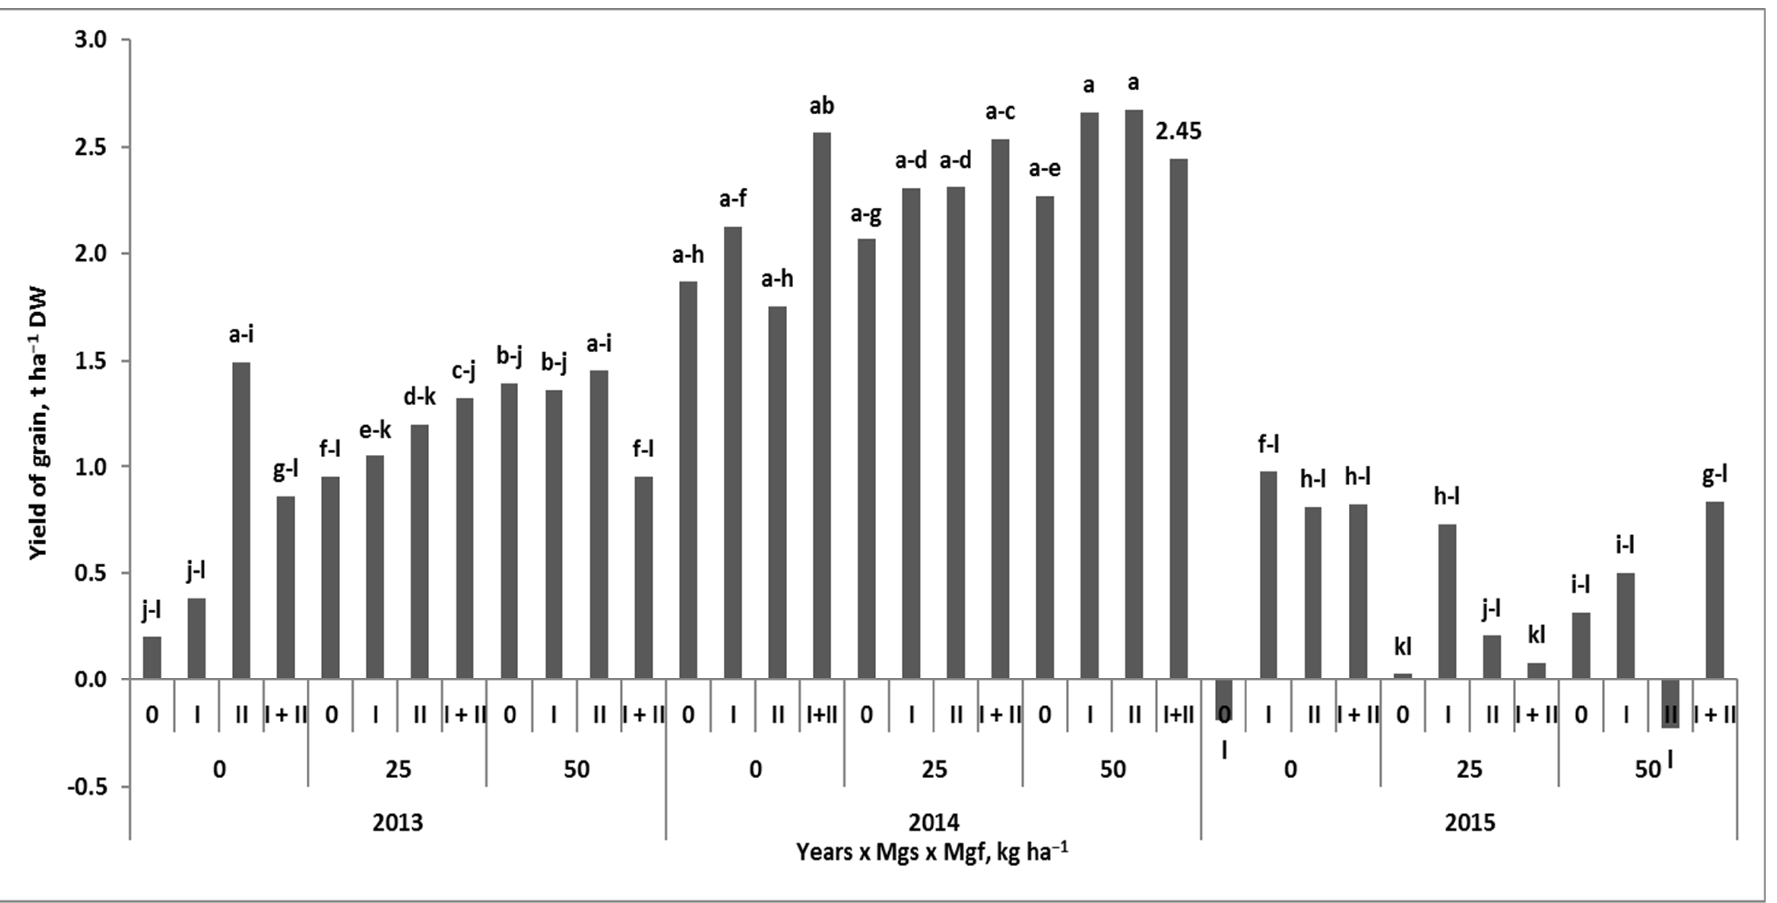
Figure 5. Effect of magnesium fertilization systems on the background of years on the increment of the grain yield of winter wheat in the maturation phase. Similar letters mean a lack of significant differences using Tukey’s test. Legend: Mgs, Mgf—soil and foliar Mg fertilization systems, respectively; I—BBCH 30; II—BBCH 49/50.